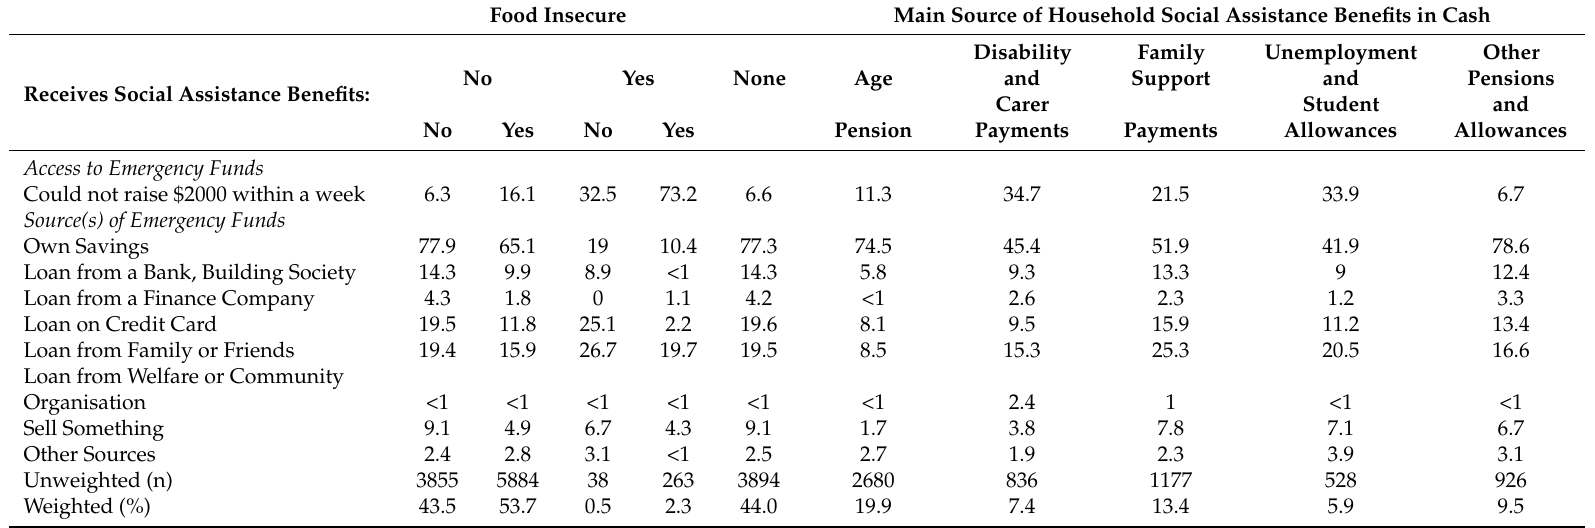
Table A3. Access to Emergency Funds (%) by Food Insecurity and Receipt of Social Assistance, Households 2015/2016. Food